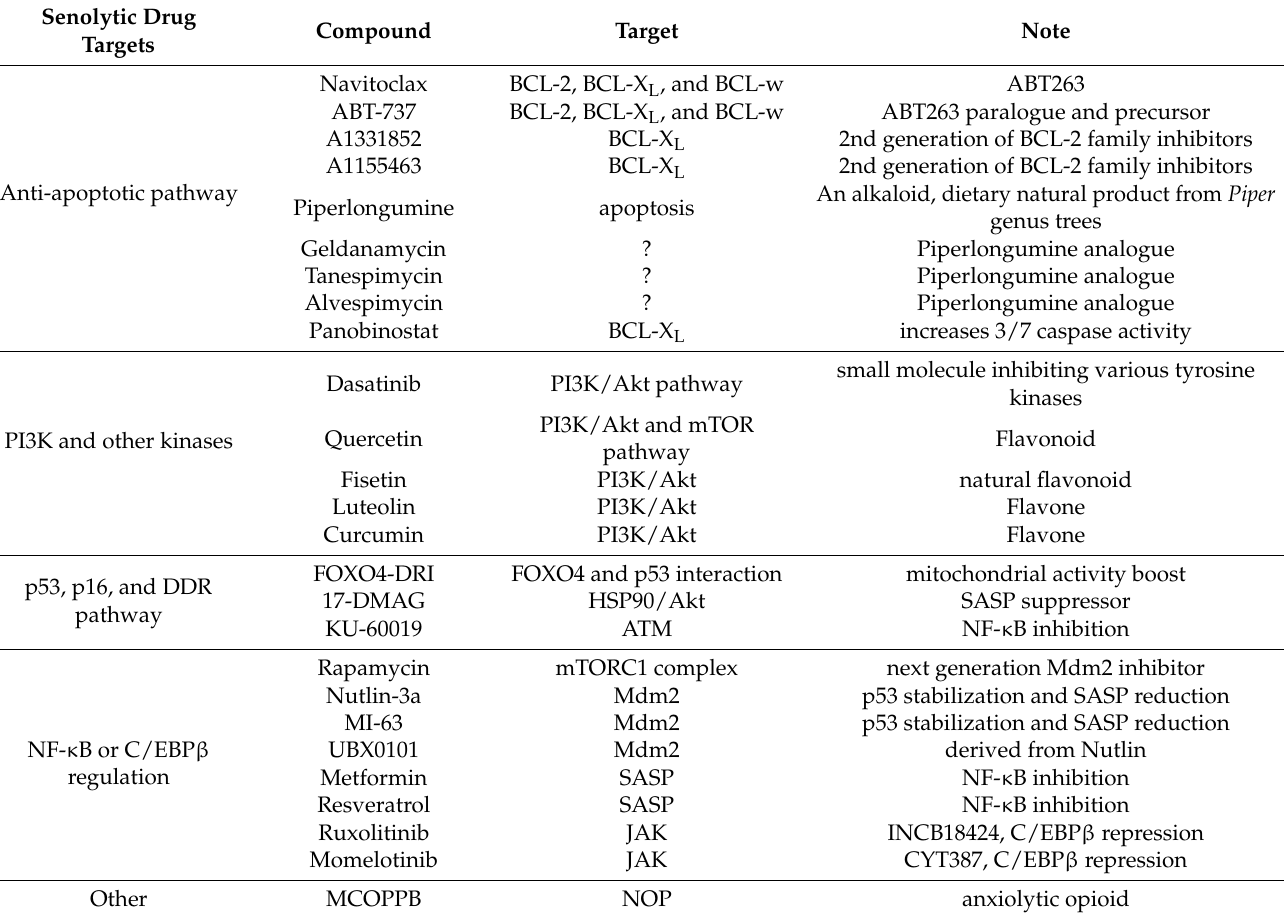
Table 3. List of senolytic